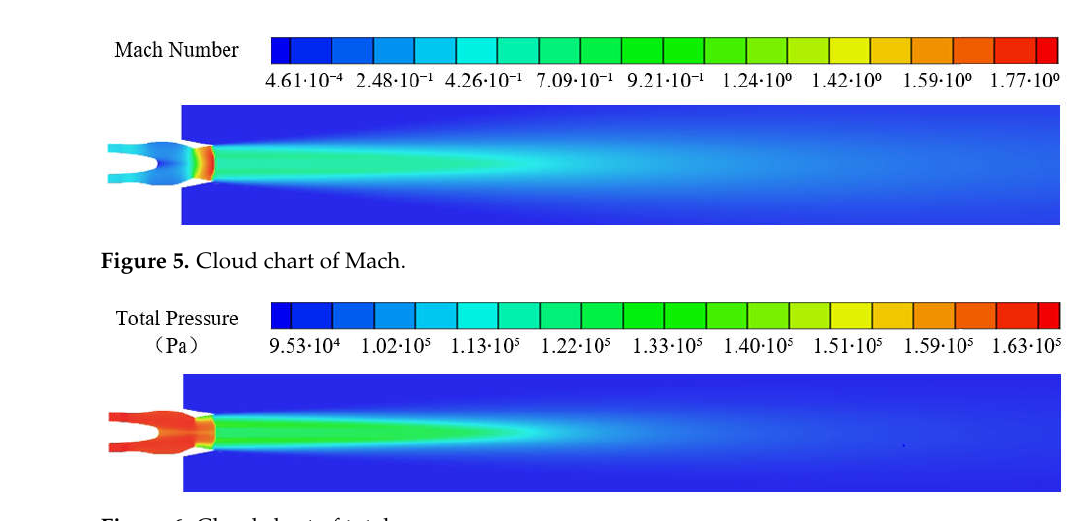
Figure 6. Cloud chart of total pressure.